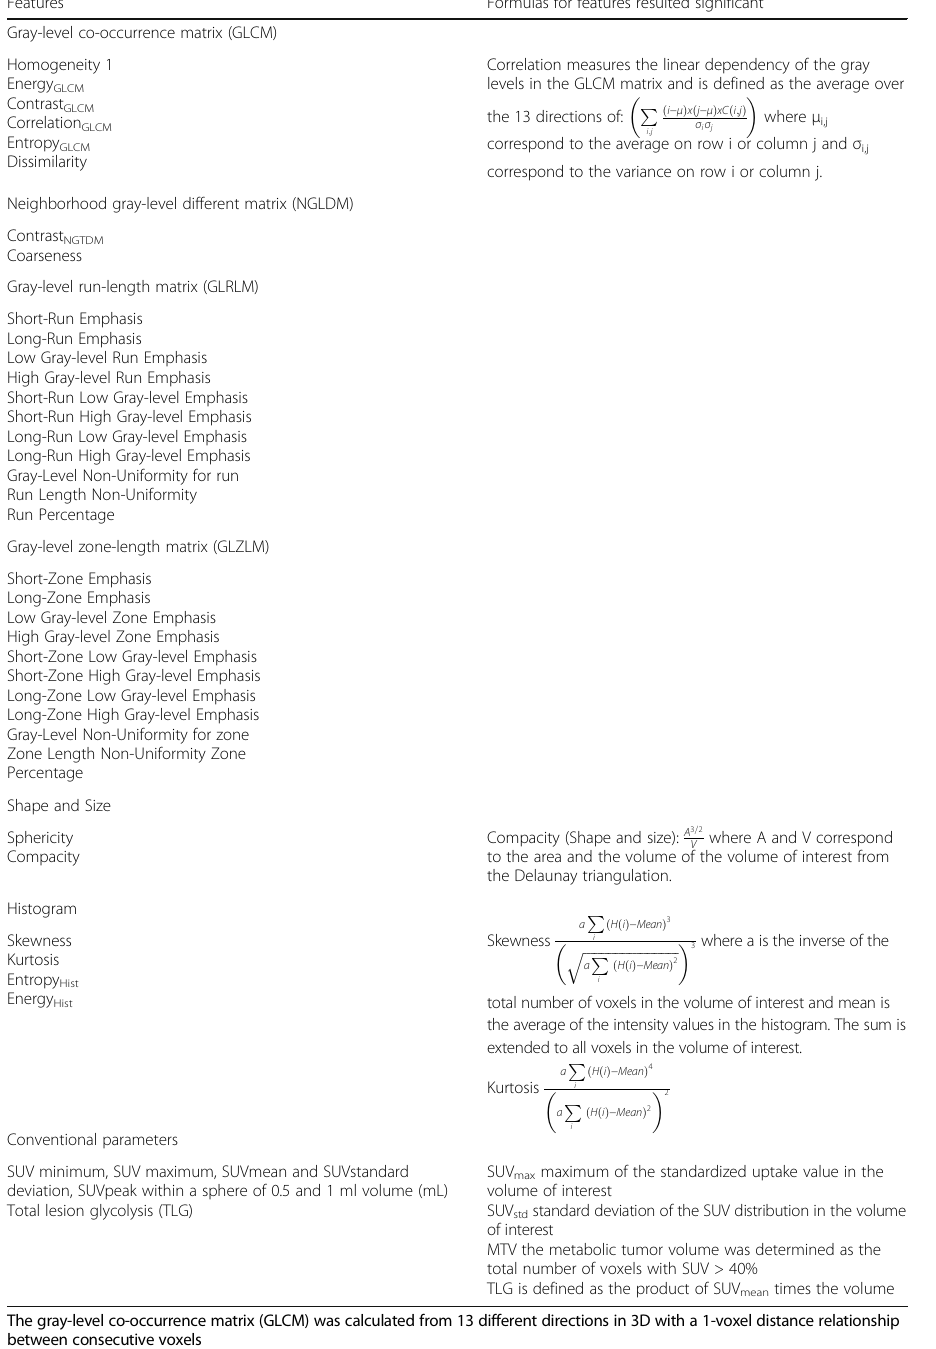
Formulas for features resulted significant